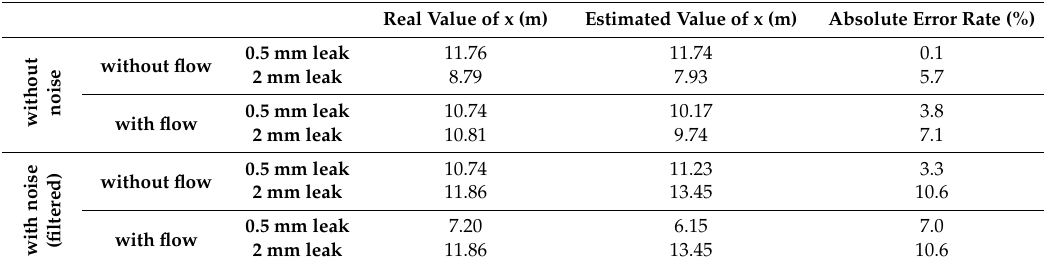
Table 5. Results from the BCC method for 15 m distance between the sensors.